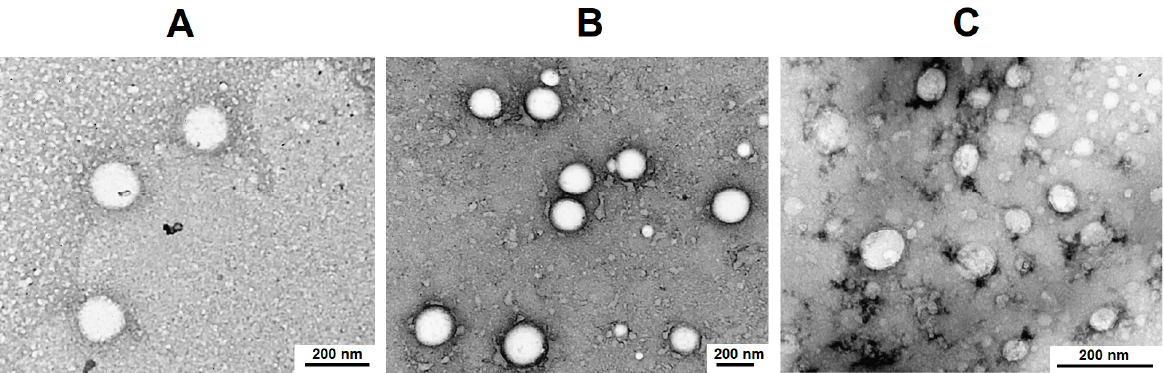
Figure 6. TEM images of empty PP ( A ), PP@PTX ( B ), and PP@PTX + oligo-dT-dA ( C ) based on the P[KK(Y)K(R)] polypeptide. Scale bar is 200 nm; staining with uranyl acetate. In ( B , C ), the PTX load was 50 µg/mg of polymer; the ratio of polypeptide/oligo-dT-dA in ( C ) was 12 ( w / w ).